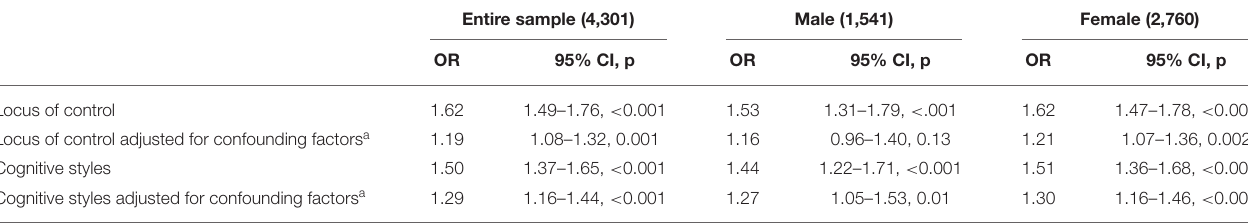
TABLE 4 | Unadjusted and adjusted odds ratio for adult depression according to continuous scores of locus of control and negative cognitive styles and stratified by sex in multiple imputed datasets. Entire sample